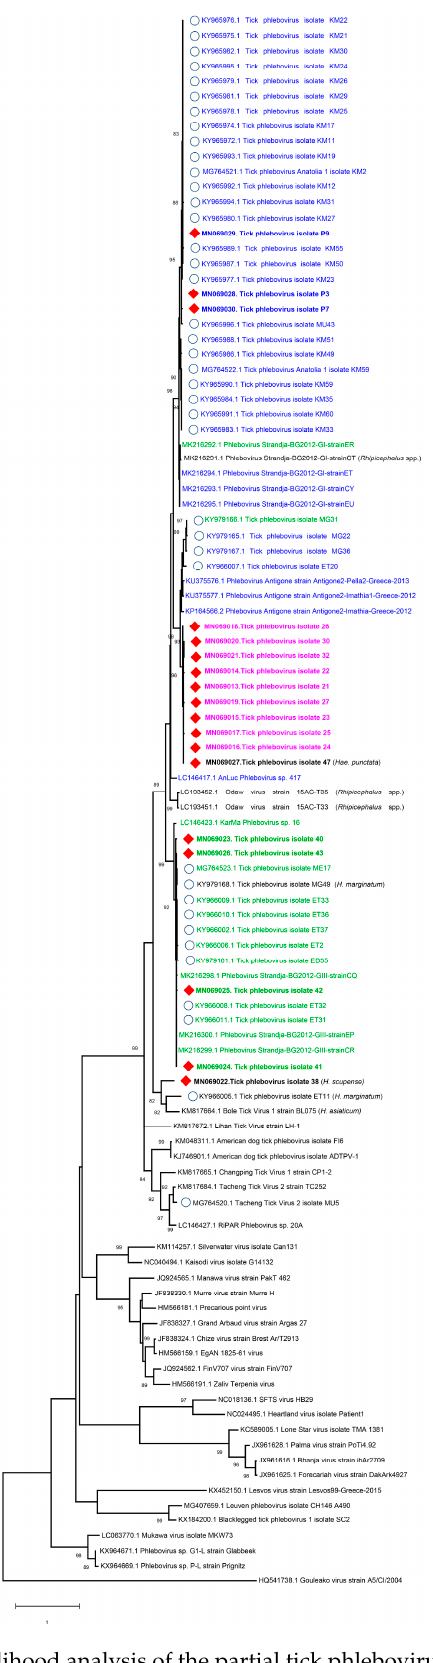
Figure 2. The maximum likelihood analysis of the partial tick phlebovirus L segment sequences (412 bp). The tree is constructed using the General Time Reversible (GTR) model, Gamma distributed with Invariant sites (G + I) for 500 replications. The sequences characterized in this study are given in